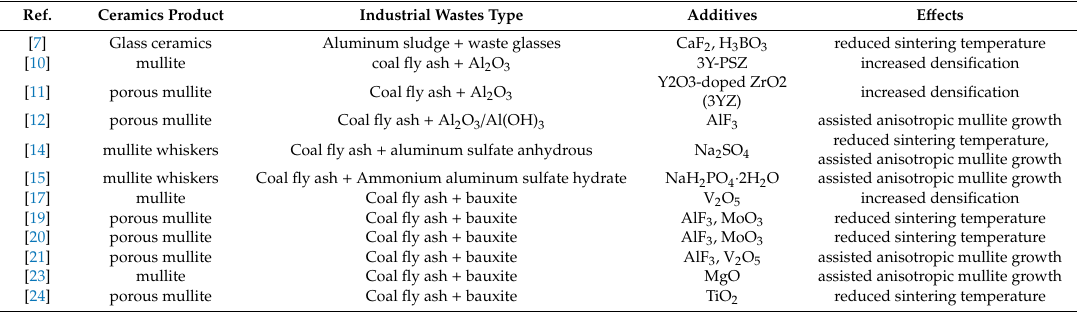
Table 2. Example of chemical additives used in the preparation processes of mullite in the literatures.